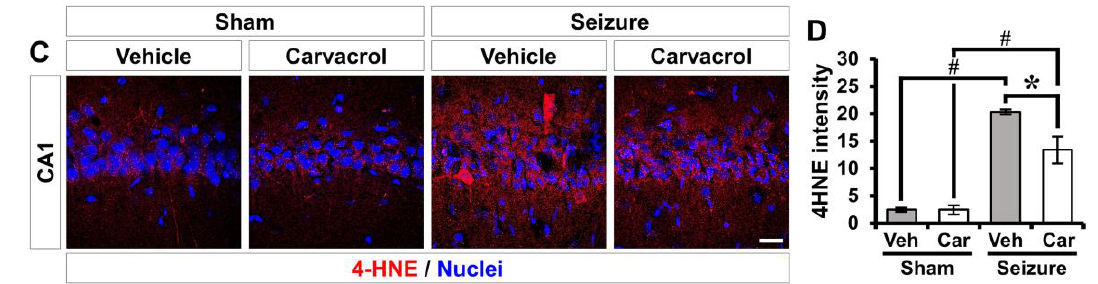
Figure 3. Carvacrol treatment reduces reactive oxygen species (ROS) production and oxidative stress after seizure. ( A ) Representative images showing the Et fluorescence in the hippocampal CA1. Scale bar = 20 µ m. ( B ) The bar graph representing the intensity of Et fluorescence as determined in the same hippocampal region (mean ± SEM; n = 6 from each sham group, n = 5–6 from each seizure group). * p < 0.05 vs. the vehicle-treated group (Kruskal–Wallis test followed by a Bonferroni post-hoc test: chi square = 16.579, df = 3, p < 0.001). ( C ) Immunofluorescent images representing the lipid peroxidation stained for anti-4HNE (red) in the hippocampal CA1. Nuclei are counterstained with DAPI (blue). Scale bar = 20 µ m. ( D ) Quantification of the immunofluorescence intensity of 4HNE as determined in the same hippocampal region (mean ± SEM; n = 5 from each sham group, n = 7 from each seizure group). * p < 0.05 vs. the vehicle-treated group; # p < 0.05 vs. the sham-operated group